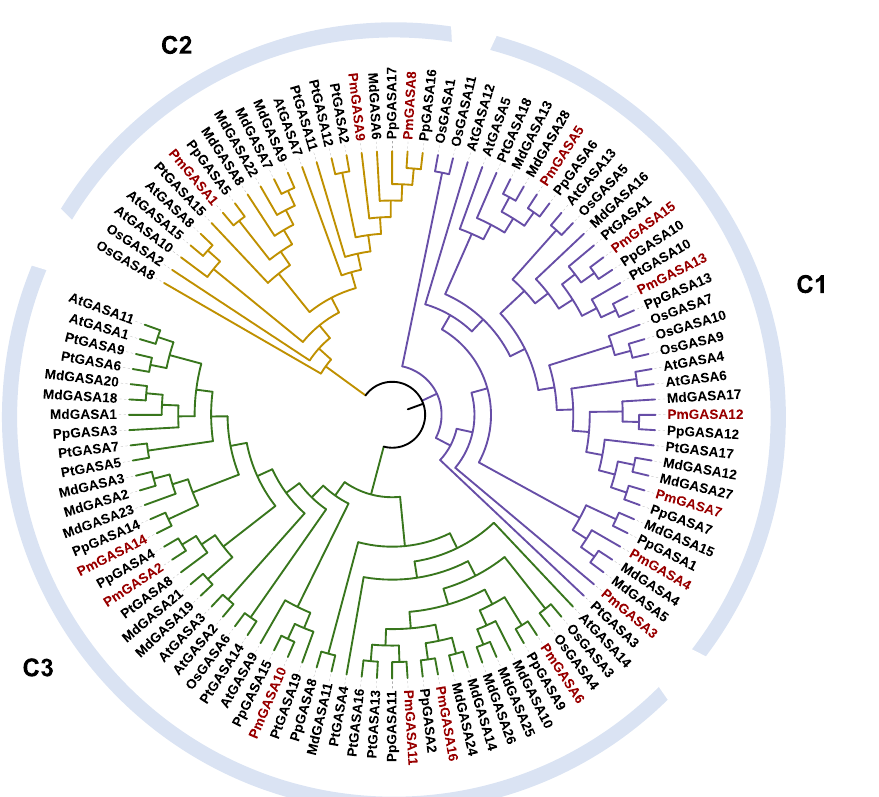
Figure 3. Phylogenetic analysis of 106 GASA family genes from six plant species based on their protein alignment. The phylogenetic tree was constructed using the NJ method, with 1000 bootstrap replicates in MEGA. The GASA genes were clustered into three clades (C1, C2, C3), each one colored differently.